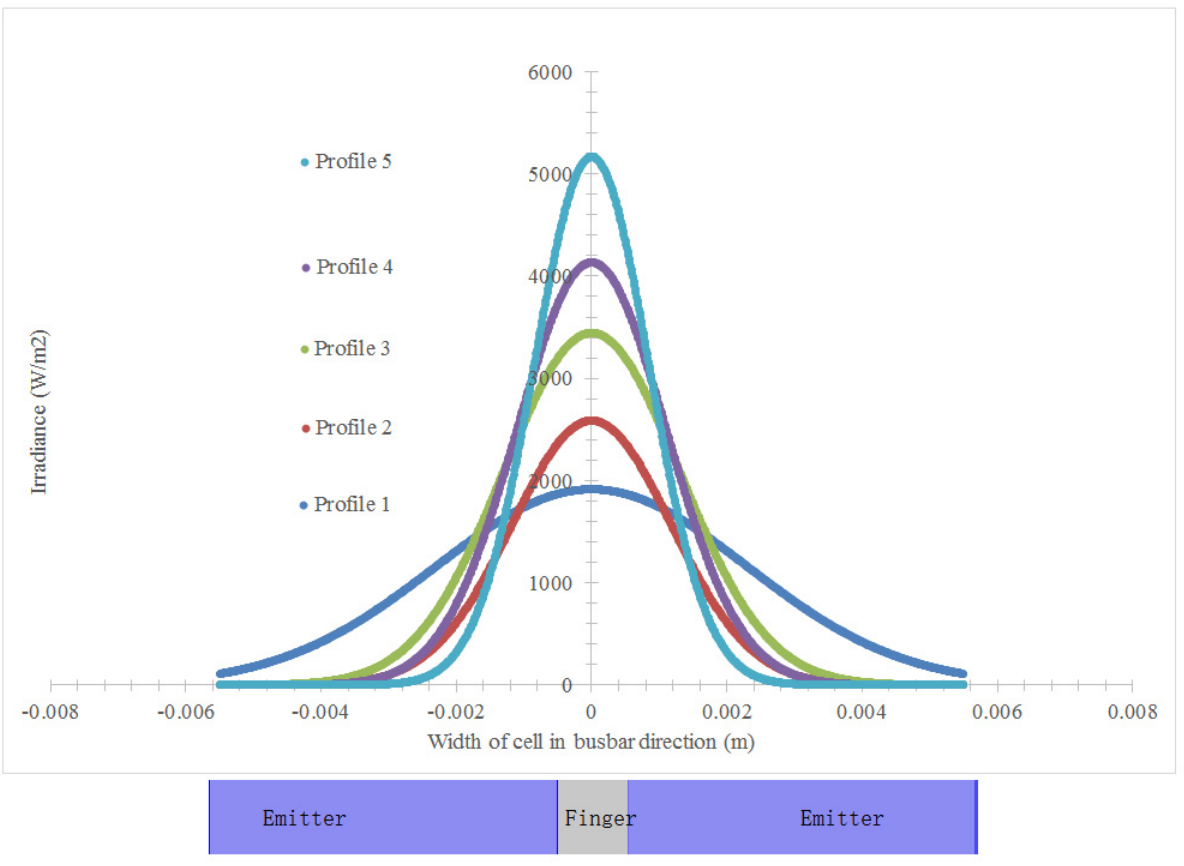
Figure 5. Illumination distribution over the cell for five illumination profiles, x-axis is the busbar direction